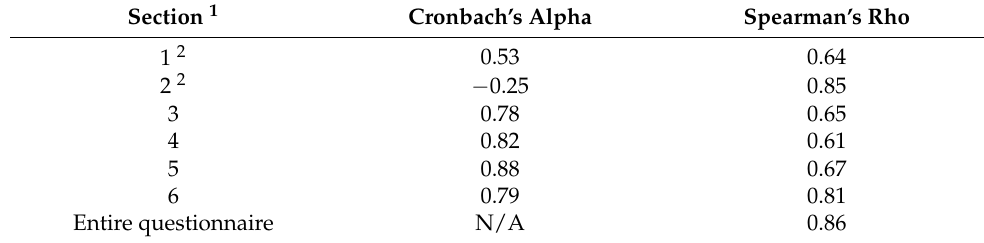
Table 1. Cronbach’s alpha and Spearman’s rho by section of the preliminary questionnaire.